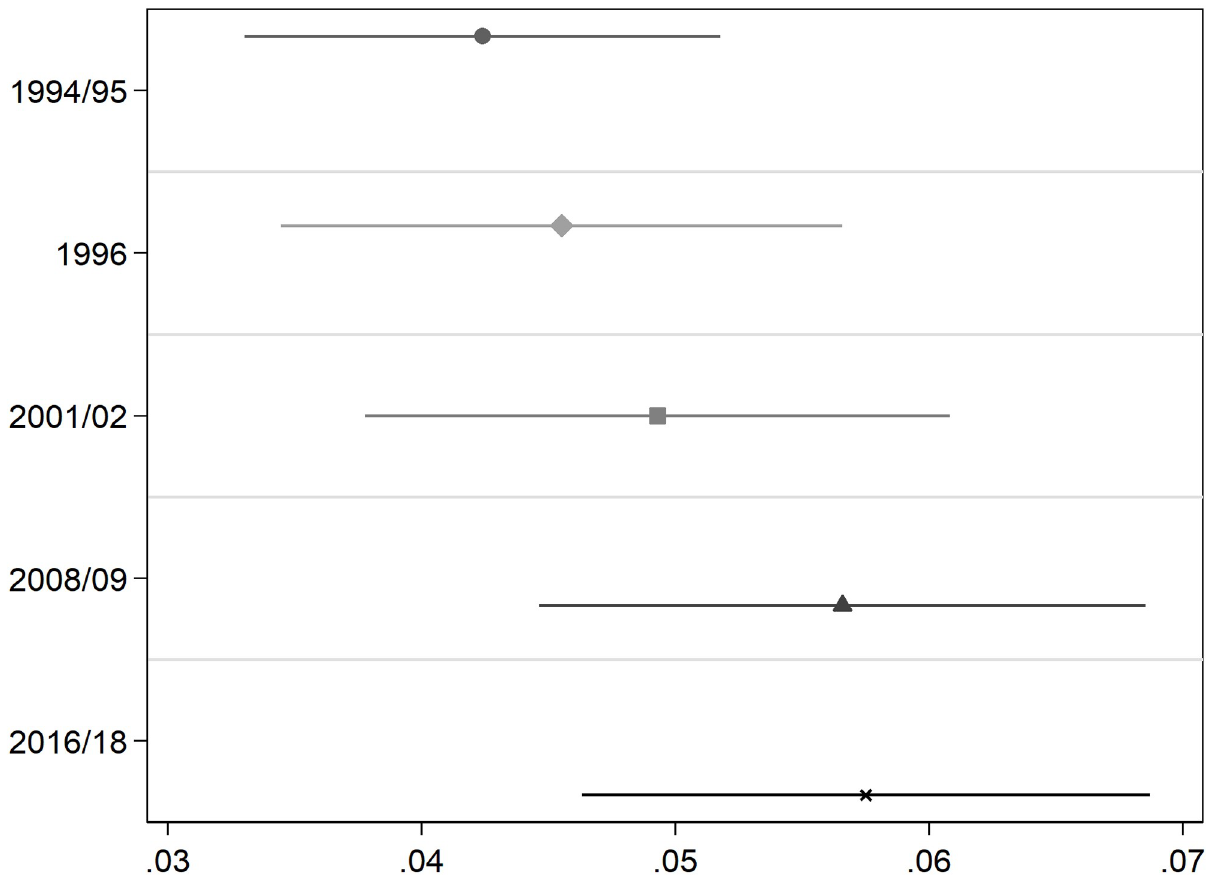
Fig 3. Association between BMI polygenic scores and Log(BMI) along the life-cycle. Add Health Cohort . This Figure summarizes the results of estimating Eq 2 on the balanced sample of 2,730 Add Health cohort members described in Table 2. The dependent variable is Log(BMI). OLS coefficient estimates of β 1 as well as their associated 95% confidence intervals are depicted. All regressions include a female dummy, age, age squared, and the first 10 principal components of the full matrix of genetic data. Standard errors are clustered at the school level. Longitudinal weights are used.